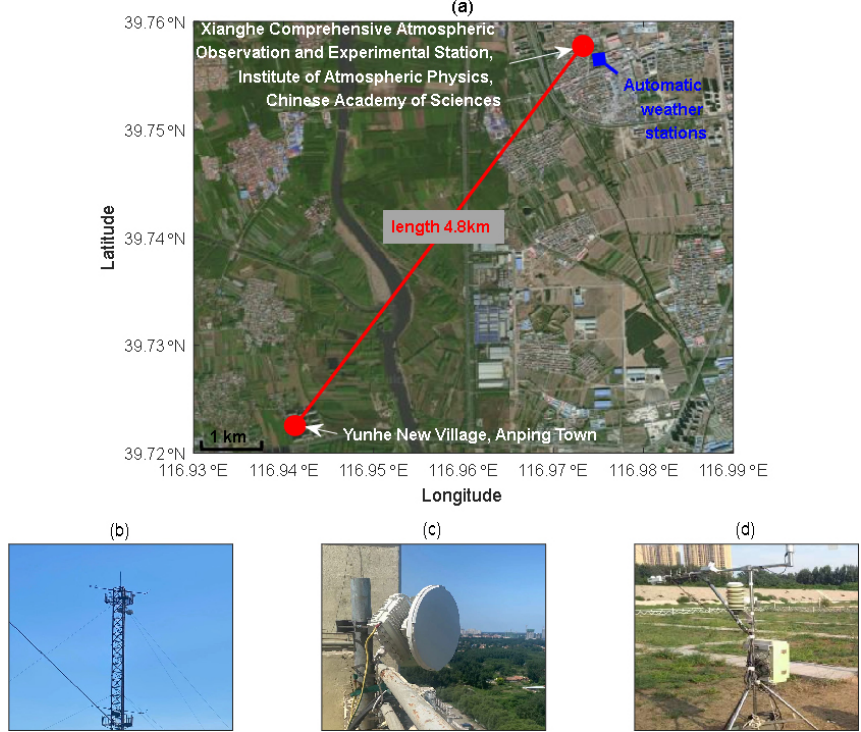
Figure 1. (a) Location of the E-band millimeter wave link (©2021 Baidu). (b) The transmitter of the link. (c) The receiver of the link. (d) The automatic weather stations in the experiment.